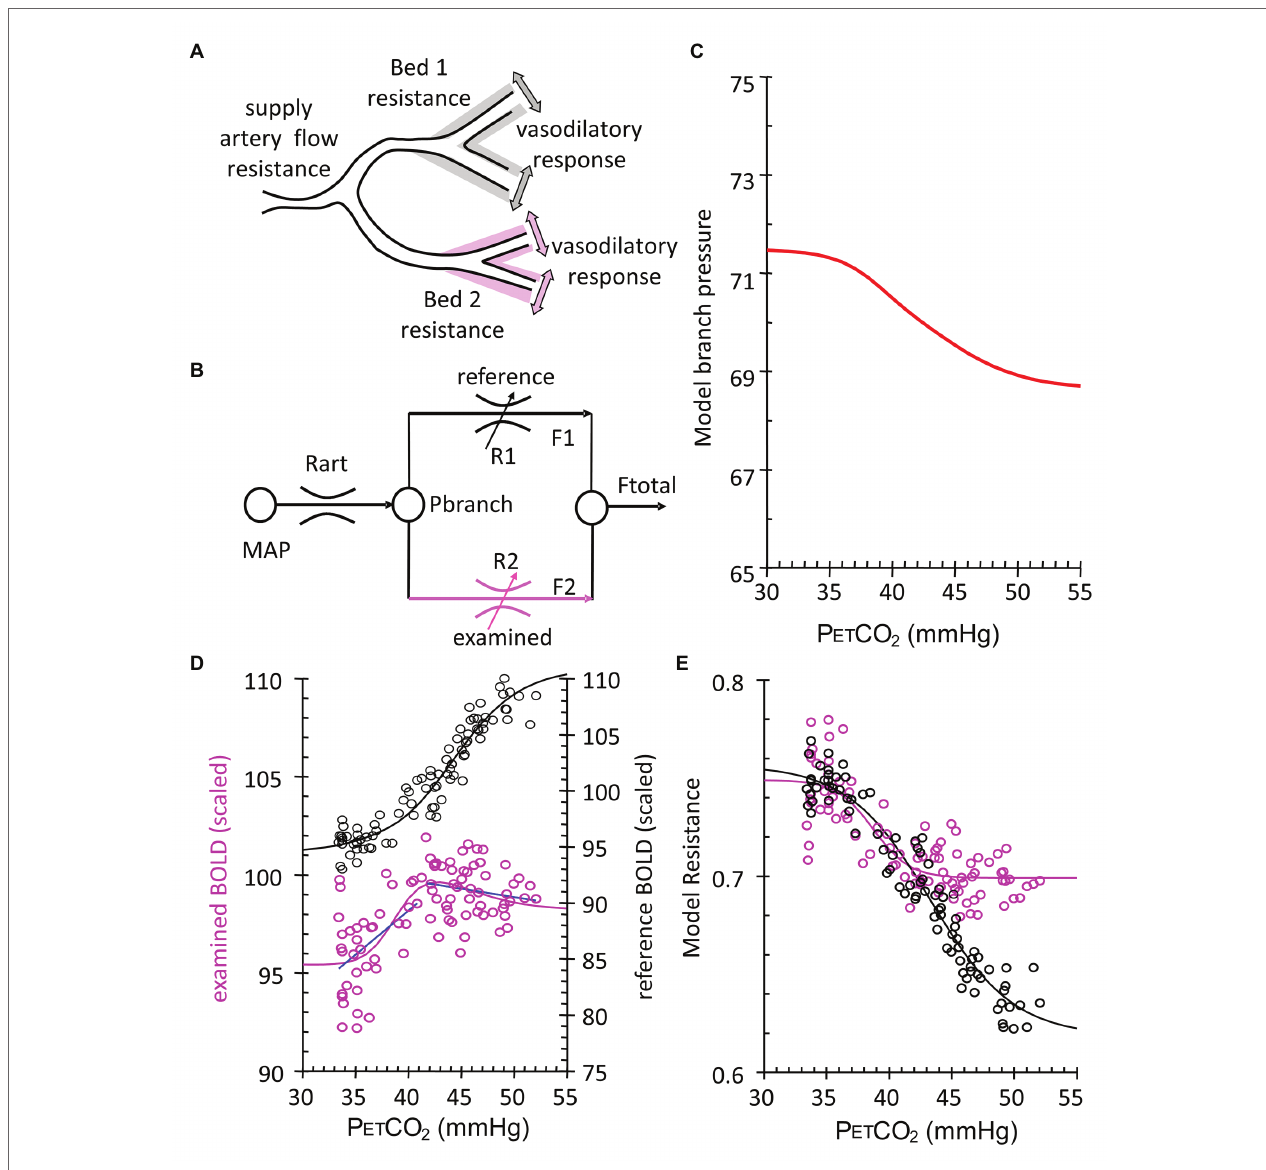
FIGURE 5 | Calculation of voxel resistance sigmoidal profile over range of PETCO 2 . (A) Theoretical illustration of two brain vascular territories both supplied in parallel by a major artery with resistance (flow limitation). Their vasodilatory responses are shown as shading. (B) Simple resistance circuit model. Reference and examined vascular beds with resistances R1 and R2 are perfused via an arterial flow resistance (Rart) from mean arterial blood pressure (MAP). The pressure perfusing the two branches (Pbranch) and their respective resistances establishes flows through each branch (F1 and F2) that sum to Ftotal. Given F1 and F2 as BOLD measures for the reference and examined voxels, R1 and R2 can be calculated by considering the Model as an analog of an electrical circuit. The Model assumes that this unit may be expanded and contracted in a fractal pattern to contain the blood supply of both hemispheres, from extracranial vessels to capillaries. Every vessel or vascular bed is considered in fluid continuity with every other vessel. As such, we use the examined bed for each unit on a voxel scale, as if it is perfused in parallel with an ideal voxel of full vasodilatory responsiveness. Pbranch values result from the assumption of MAP = 100 mmHg and the pressure loss in Rart assumed to be 30 mmHg (Faraci and Heistad, 1990). Regardless of flow pattern Type ( Figure 4 ), the calculation invariably results in a sigmoidal resistance response to PETCO (lines) are fitted to the resistance-CO 2 responses for each